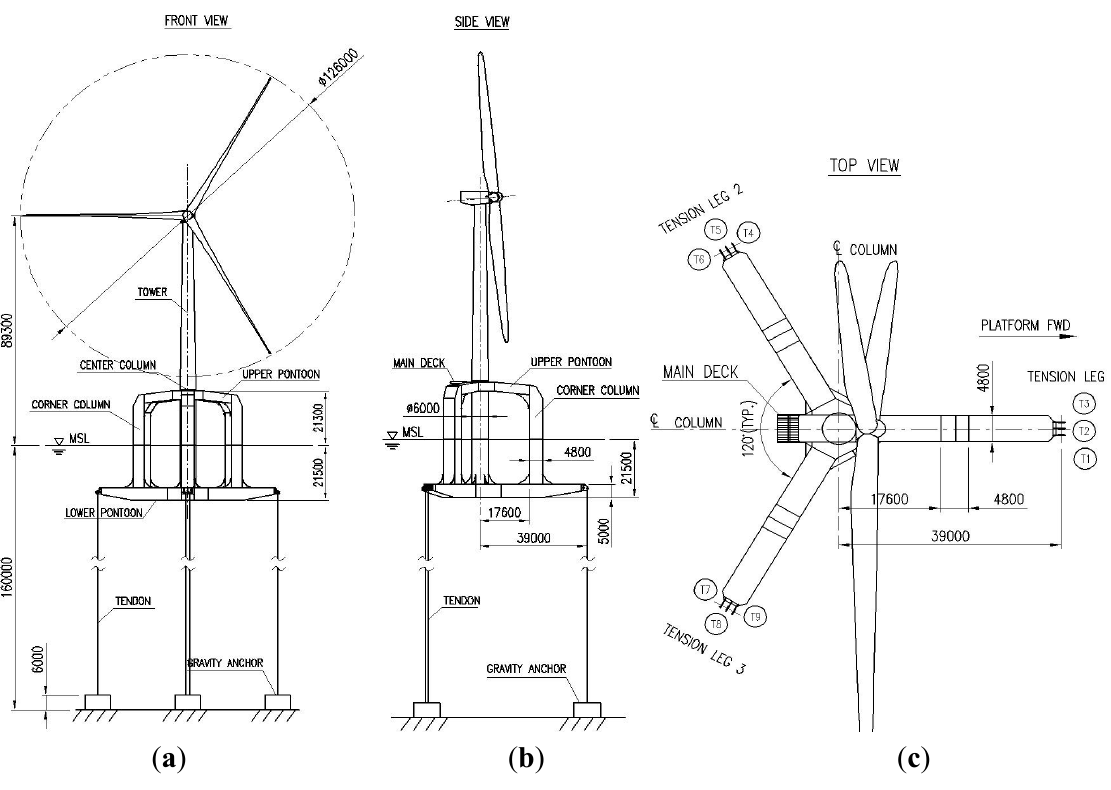
Figure 6. General arrangement of the WindStar TLP system: ( a ) Front view; ( b ) Side view; ( c ) Top view.